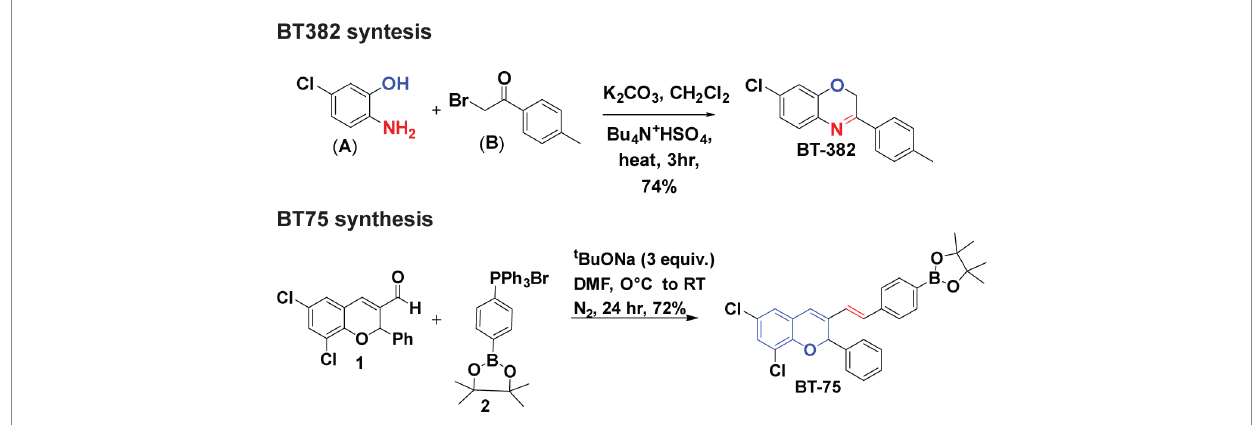
FIGURE 1 Synthesis of BT382 and